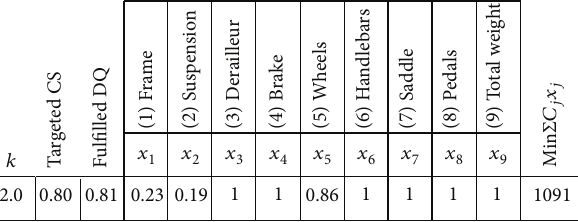
Figure 8: Optimal technical fulfillments for